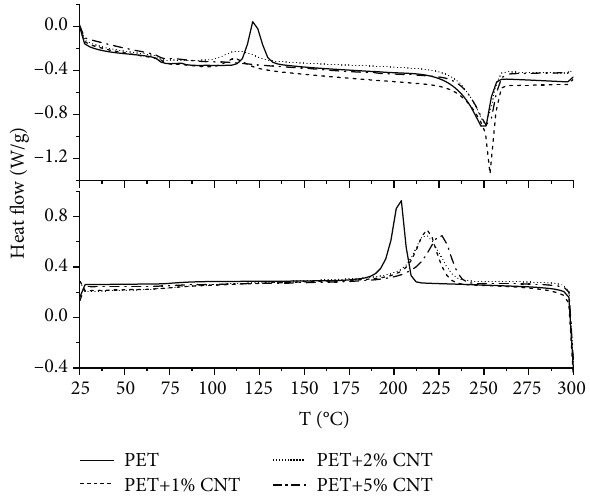
Figure 3: PET/CNT nanocomposite DSC heating and cooling